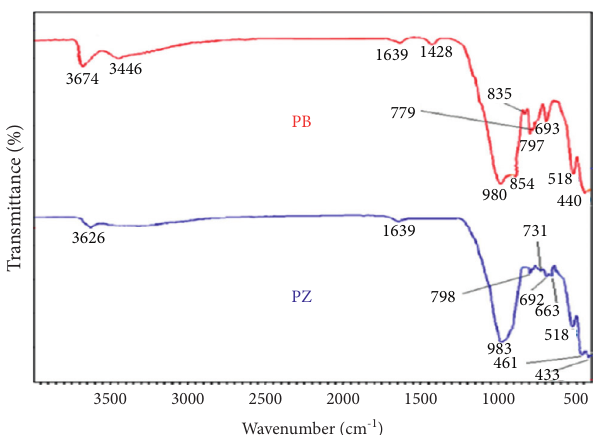
Figure 9: FTIR spectra of samples: natural clay (PB) and pyro- phyllite (PZ) adopted from [3].